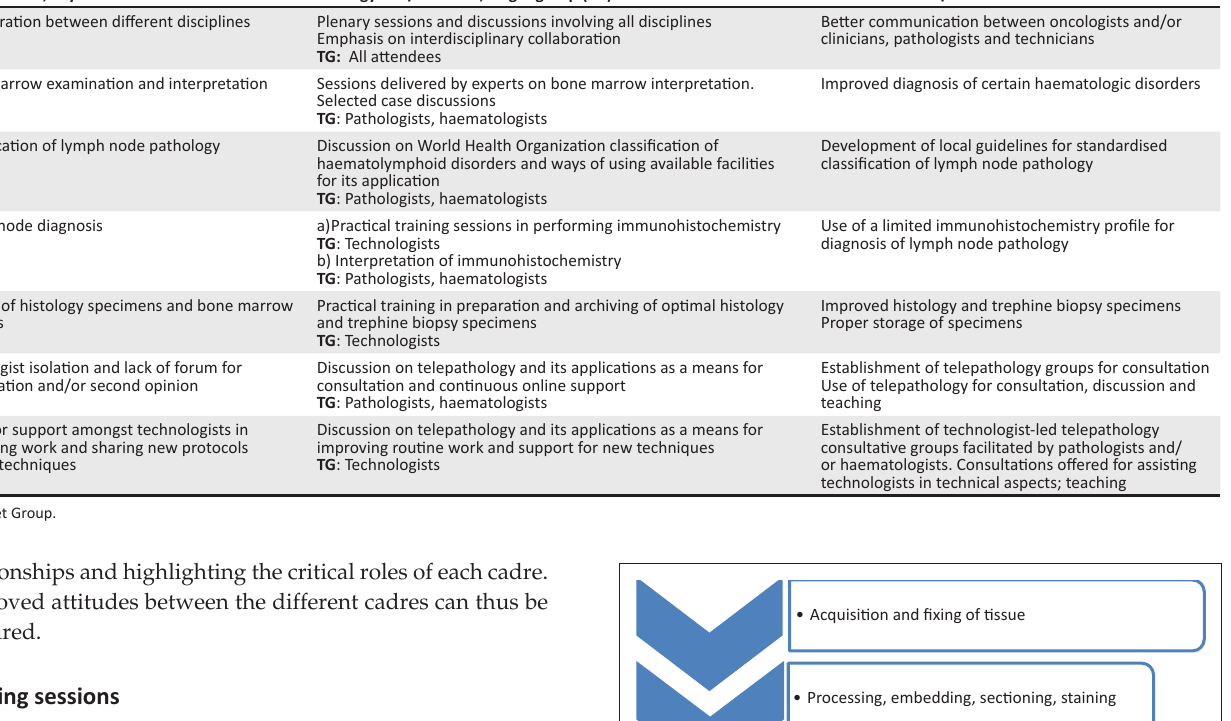
haematologist• Processing, embedding, sectioning, • Analysis and reporting • Requires input from clinician/oncologist and